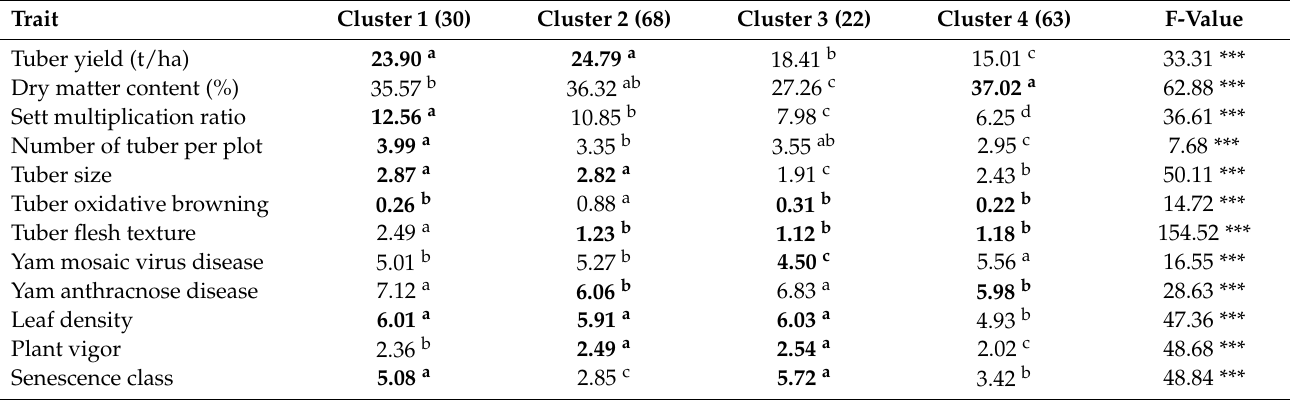
Figure 3. Hierarchical clustering showing grouping patterns of yam landrace accessions into four clusters using twelve key traits covering agronomic and tuber quality based on the Gower dissimilarity matrix. C1, Cluster one (blue); C2,; Cluster two (yellow); C3, Cluster three (green); C4, Cluster four (red). D. praehensilis (2). Table 7. Description of clusters of yam landraces.